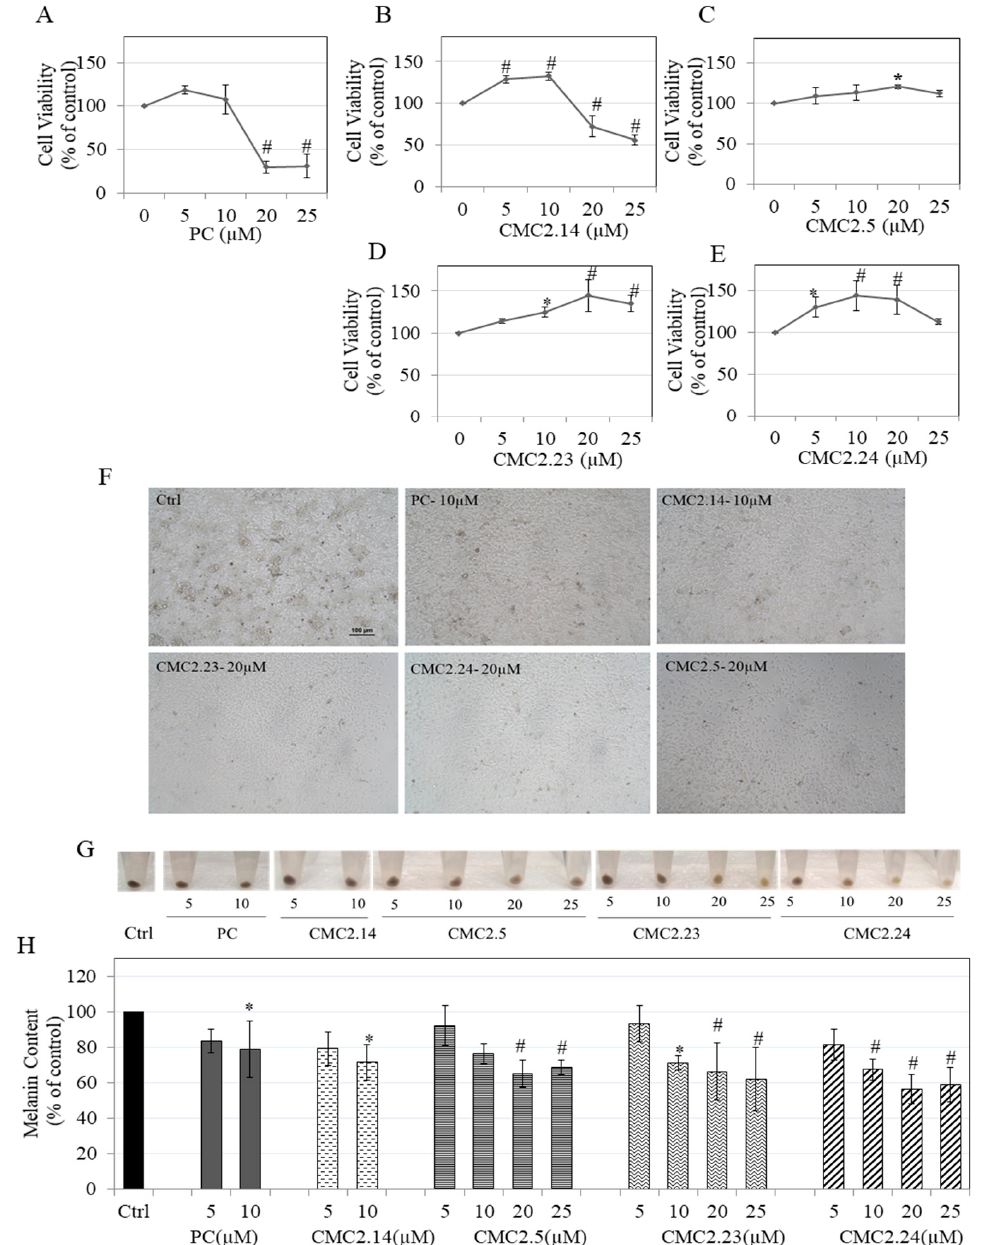
Figure 5. Viability of B16F10 cells treated for 48 h in the presence of different concentrations of PC and CMCs; ( A ) PC; ( B ) CMC2.14; ( C ) CMC2.5; ( D ) CMC2.23 and; ( E ) CMC2.24, measured using MTS cytotoxicity assay. * p < 0.05 and # p < 0.01 vs. control; ( F ) Representative images of B16F10 cells showing the control group and treatment groups (PC and CMC2.14 (10 µM), CMC2.5, CMC2.23 and CMC2.24 (20 µM)); Melanin content estimation with different concentrations of PC and CMCs showing ( G ) Cell pellet panel shows representative images from one experiment and; ( H ) quantification of relative melanin levels expressed as % of control. Control was treated with 0.16% DMSO. * p < 0.01 and # p < 0.01 vs. control; One-way ANOVA with Dunnett’s post hoc test; All data are mean ± SD of at least three independent